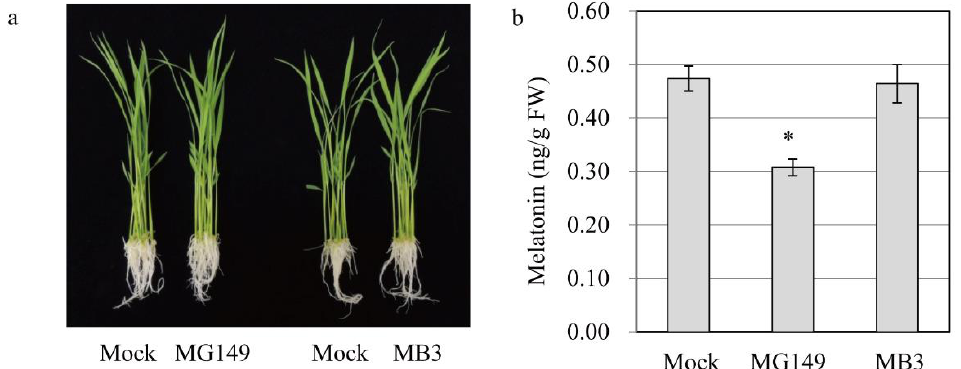
Figure 3. Quantification of melatonin in rice seedlings in response to MG149 and MB3. ( a ) Photograph of rice seedlings treated with inhibitors for 24 h. ( b ) Melatonin content in 7-day-old rice seedlings rhizosperically treated with 100 μM inhibitor for 24 h and subjected to HPLC analysis for melatonin quantification. The mock contained 0.1% ethanol. Asterisk (*) indicates significant difference from the mock control (Tukey’s HSD; p < 0.05).